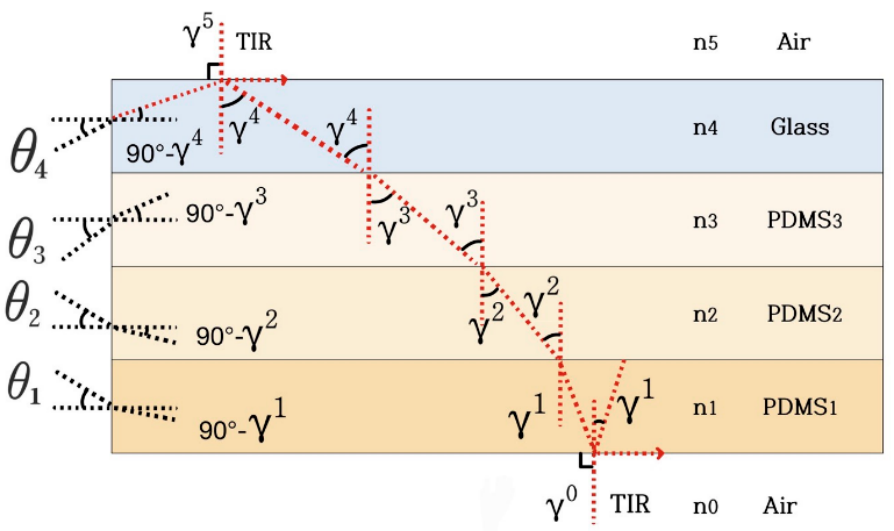
Figure 11. Expressions of light propagation in a waveguide at the propagation angles of θ i , where i = 0, 1, 2, 3, 4, 5.